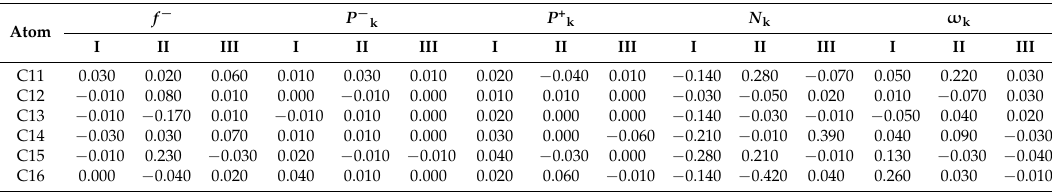
Table 10. Selected local reactivity parameters of I – III